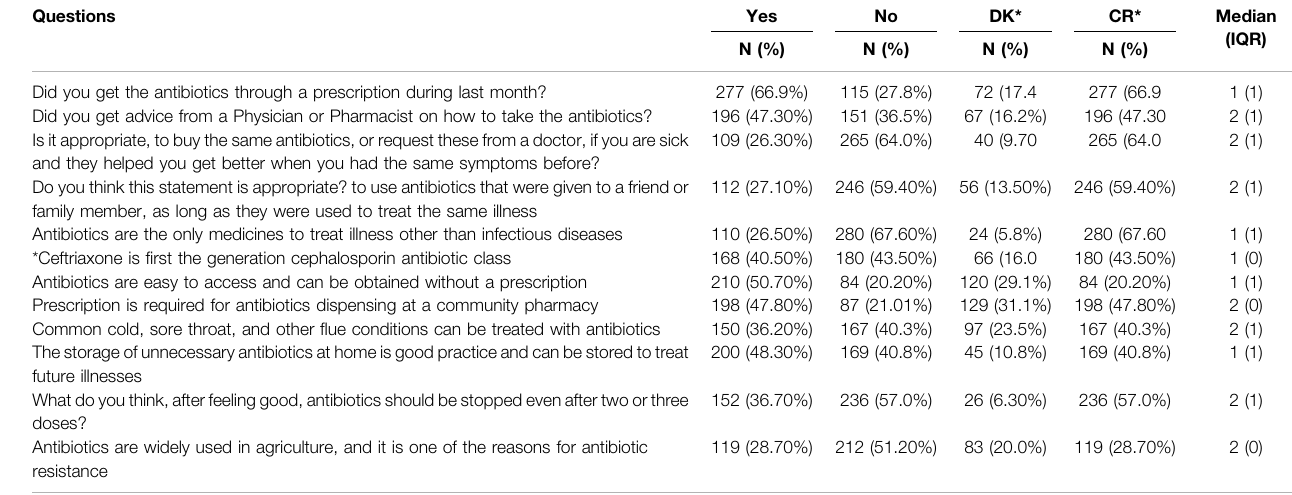
TABLE 2 | Exploring antibiotics knowledge and antibiotic